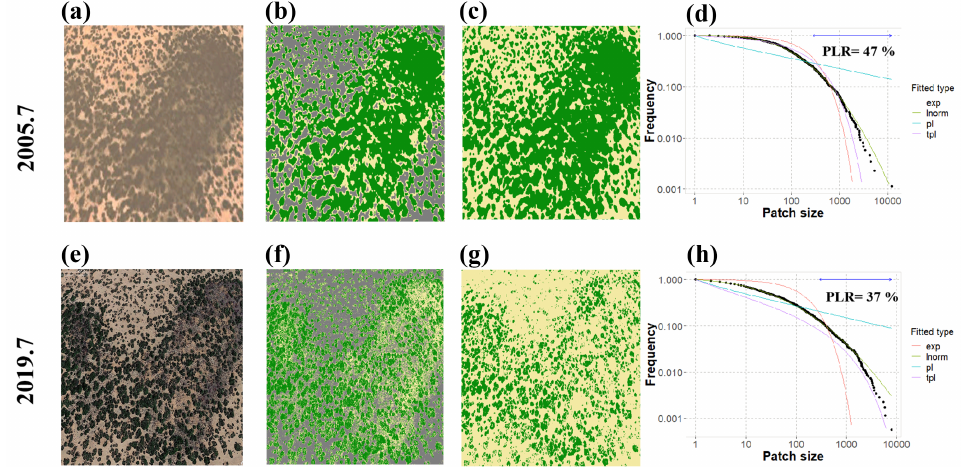
Figure 7. Site 1 in the JER (32.33°N, 106.51°W). Images taken from Google Earth for two different times. ( a , e ) are the observational images. ( b , f ) show the vegetation patches selected from the raw image. ( c , g ) are obtained from the second column’s image using the Gaussian filter. ( d , h ) are the power law ranges of the relationship between the patch frequency and PSD fit. Red line: exponential fitting. Green line: lognormal fitting. Blue line: power law fitting. Purple line: truncated power law fitting. The results are shown using logarithmic